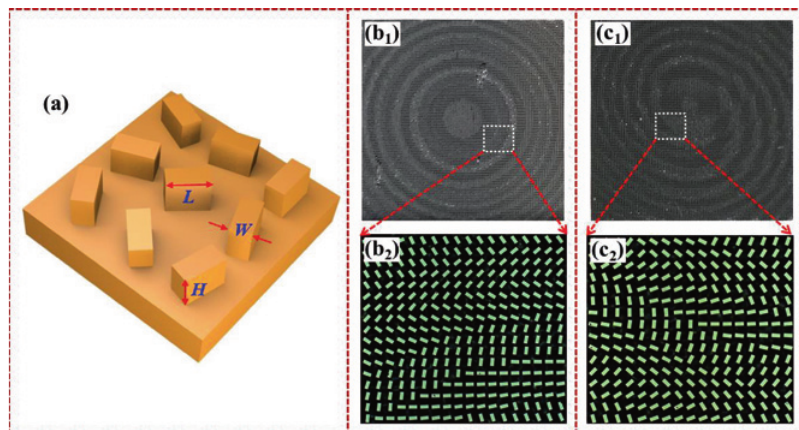
LCP incident THz waves, we observe one focal point in the left side, while another one in the right side under the illumination of RCP THz waves (see Figure 3(c )), indicating 1 a metalens with longitudinal spin-dependent splitting. The electric fi eld distributions in the x - y plane also demonstrate that only one circular-shaped spot is observed at z = 3.8 mm (or z = 6.6 mm) for the incidence of LCP (or RCP) THz waves. Here, the intensities of these two helicity-dependent focal spots are different, which can be attributed to the different focal lengths. The experimental measurements of such spin Hall metalens are shown in Figure 3(d sional spin-dependent splitting under the illumination of an ) ∼ 3(f ). In 1 3 experiment, the incident x -polarized LP THz beam is focused into two separated focal spots away from the two focal spots with longitudinal and transverse spin- sample, as shown in Figure 3(d ). In comparison with 1 tudinalcenters at z = 3.8 mm and z = 5.7 mm,which are close Figure 3(a ) and 3(d ), both the numerical simulations and 1 1 measured results are matched well with each other, except for a slight discrepancy in the size of focal spots. It can be attributed to the fabrication error and the non-perfect signal-to-noise ratio (SNR) of the THz source (in experi- ment). The electric fi eld distributions for LCP and RCP incidence of THz waves are shown in Figure 3(e ) and 3(f ). 1 1